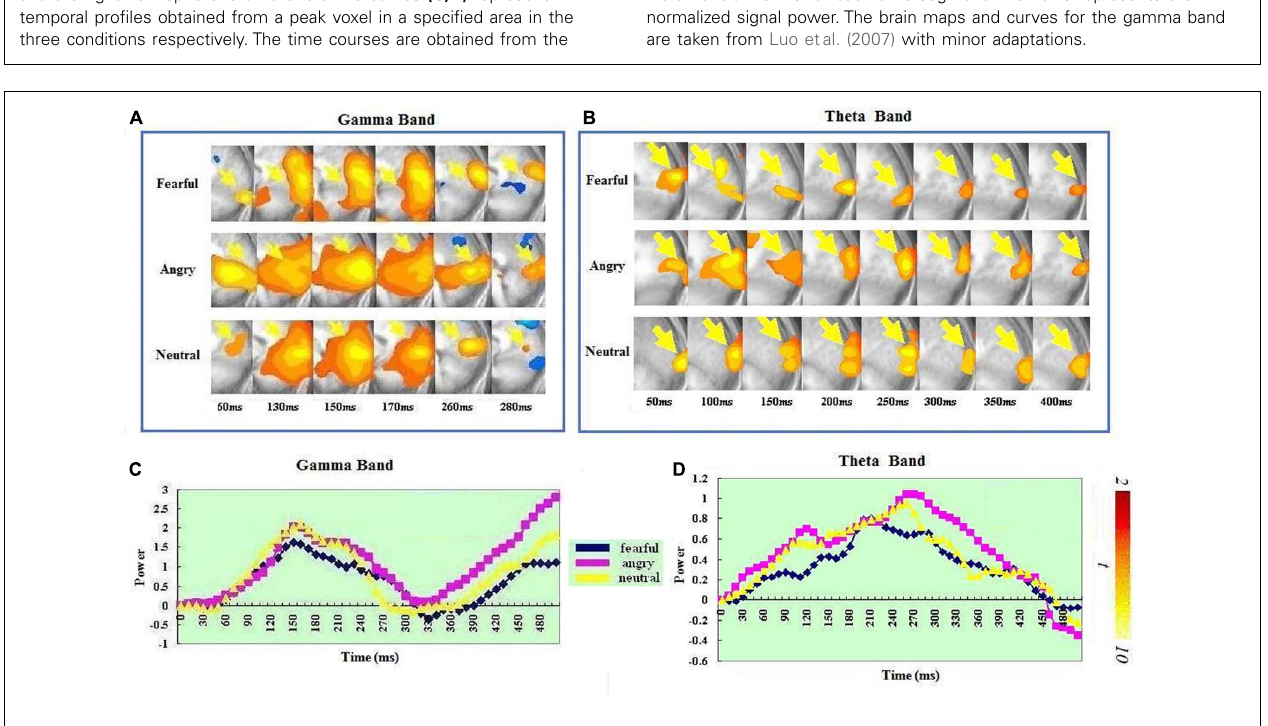
FIGURE 2 | Spatiotemporal profiles for the visual cortex in the gamma and theta bands. The brain map series (A,B) indicate the ERS development in specific brain areas with the left hemisphere is on the right and the right hemisphere is on the left. The curves (C,D) represent temporal profiles obtained from a peak voxel in a specified area in the three conditions respectively. The time courses are obtained from the